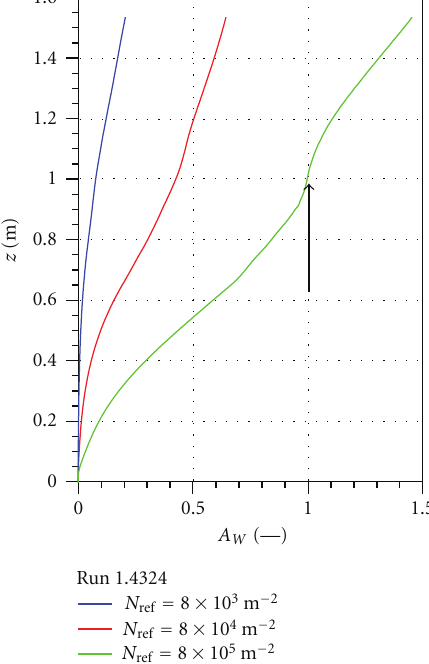
Figure 4: Bubble influence area A W